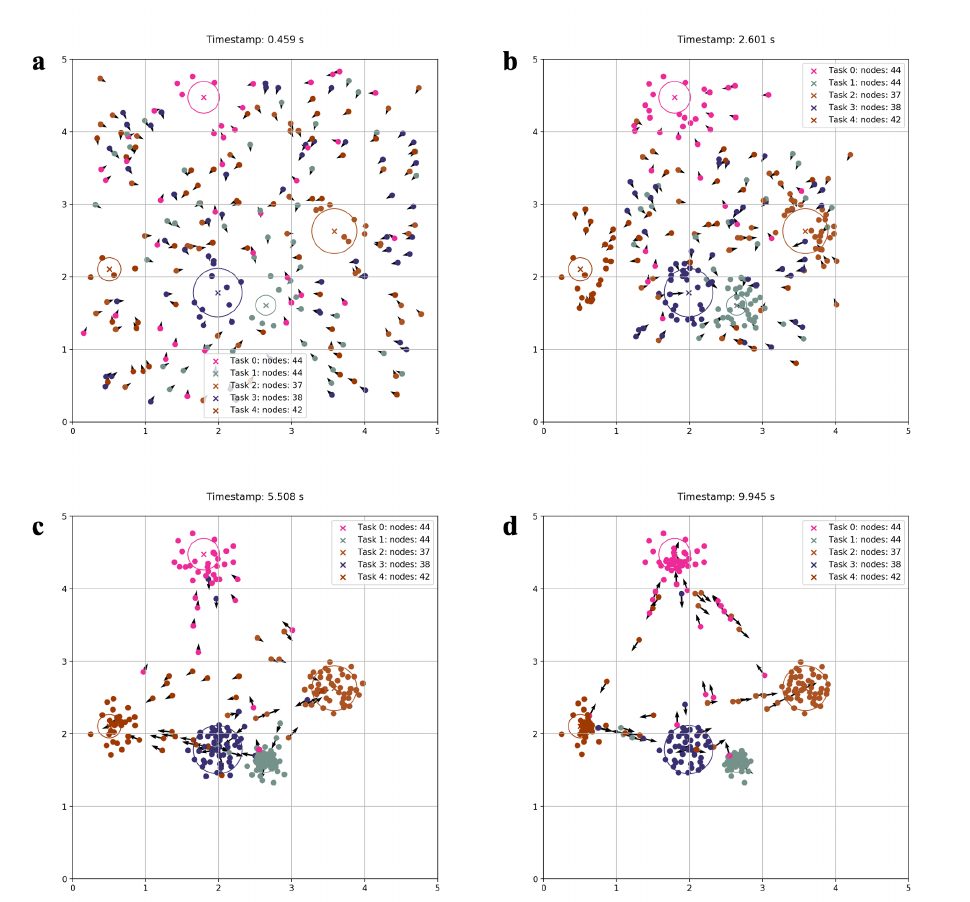
Figure 9. Illustration of a procession in time ( a – d ) of a simulation with 5 randomly placed tasks, with random radii, in a 5 × 5 unit field, where 250 nodes are placed at time 0 at random locations. Each task is associated with a random color seen in the legend. The color of each node represents its target task. The small black arrow of each node indicates the direction and magnitude of the velocity of said node. In the legend “Task 0: nodes: 9” represents a task with ID 0 and expected 9 nodes to aggregate. The parameters used to run the simulation were (cid:126) θ RFRmin seen in (25) and obtained by minimizing the hypercurve obtained by Random Forest